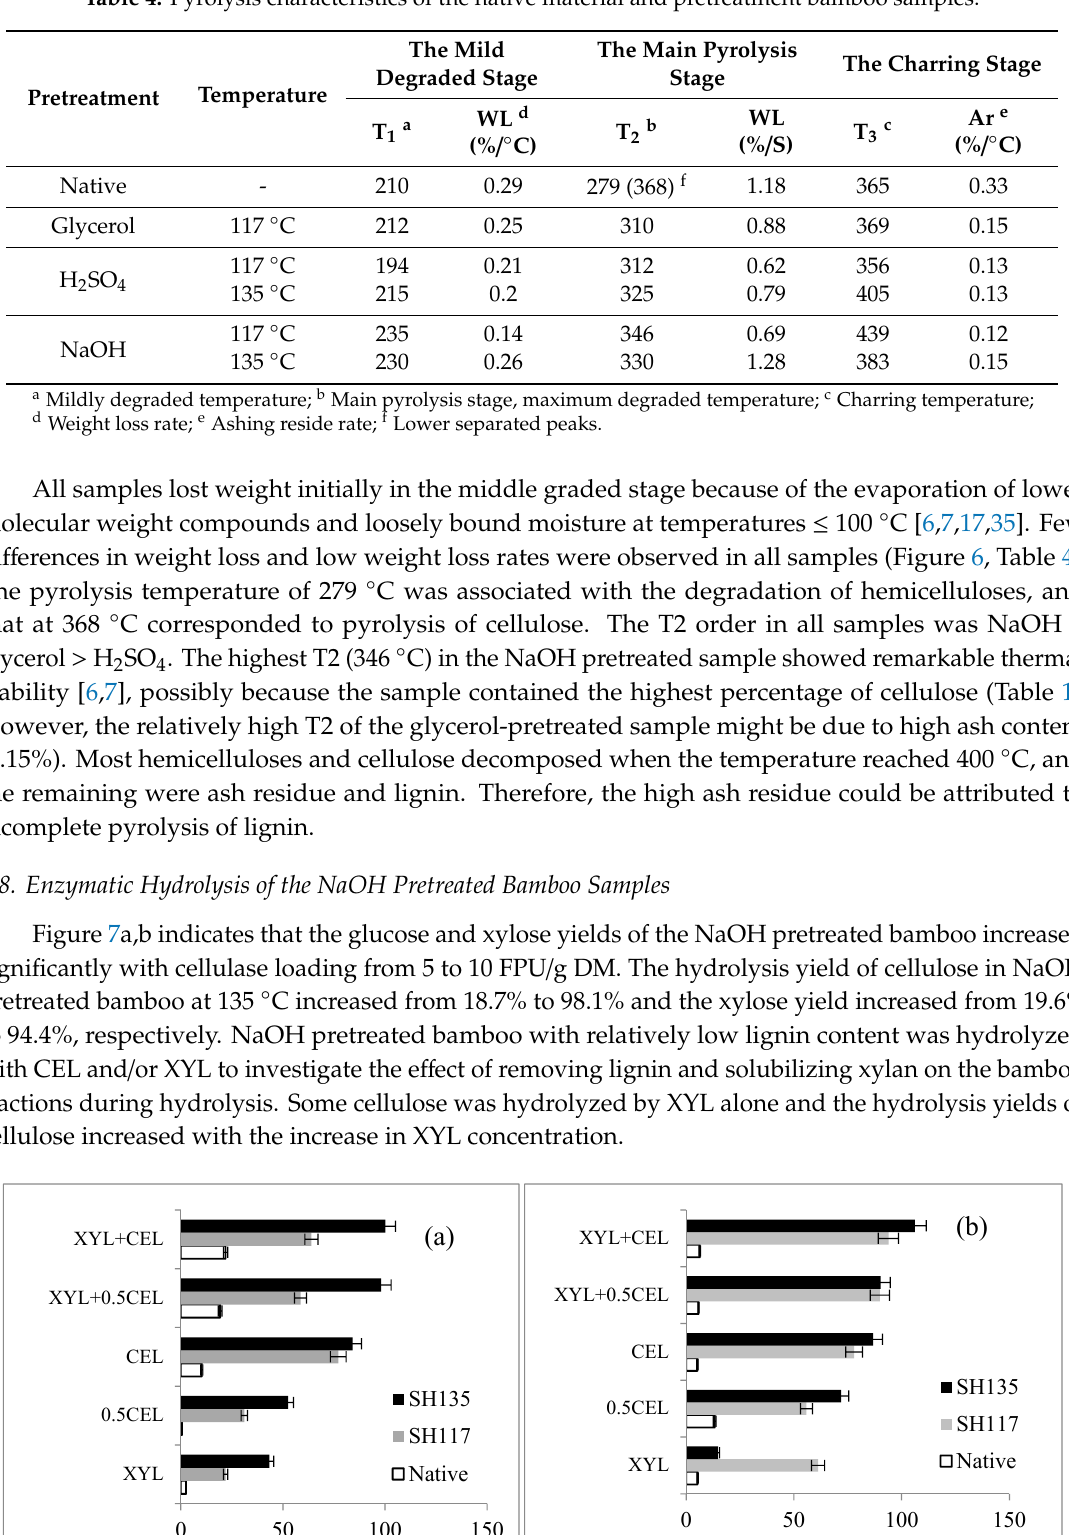
Table 4. Pyrolysis characteristics of the native material and pretreatment bamboo samples.